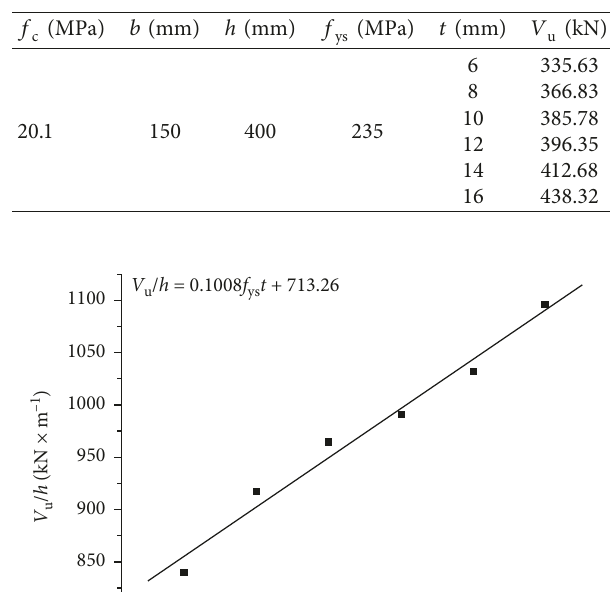
Figure 15: Fitting curve of concrete combination coefficient. Table 5: The parameters of the example.